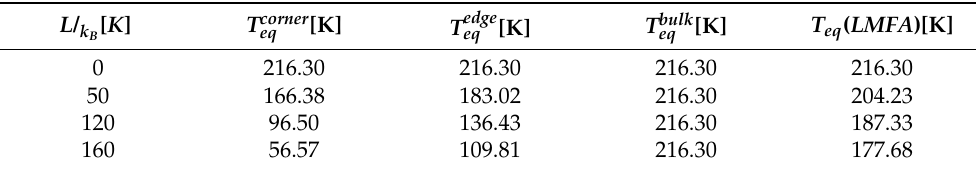
Table 3. Equilibrium temperatures of the corner, edge, and bulk calculated for different values of the L parameter for the H6 system (91 atoms). The computational parameters were ∆ / k B = 1300